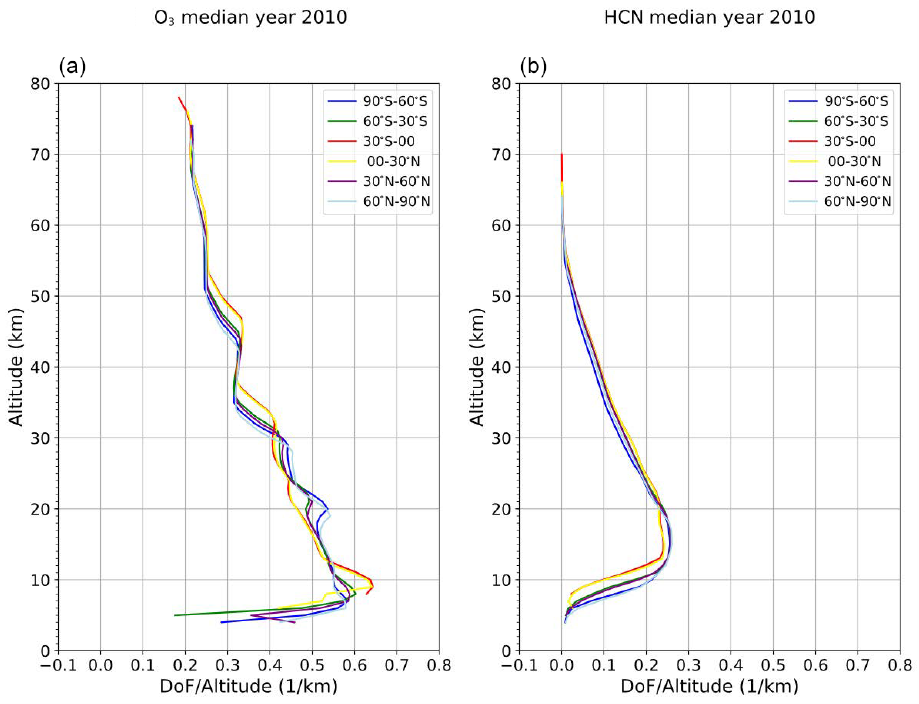
Figure 7. Examples of average profiles of DOF–altitude for a species retrieved using a posteriori regularisation (ozone, a ) and for a species retrieved with OE (HCN, b ). The different colours correspond to the different latitude bands as reported in the figure legends.